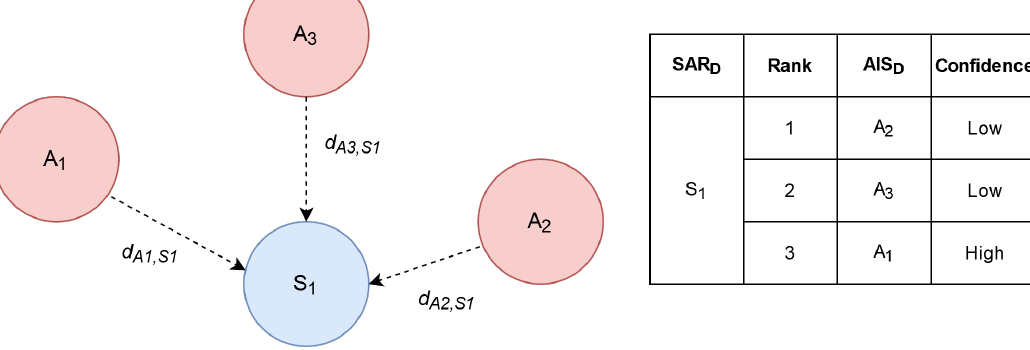
Figure 6. Final assignment concept. Table 4. Determination of confidence